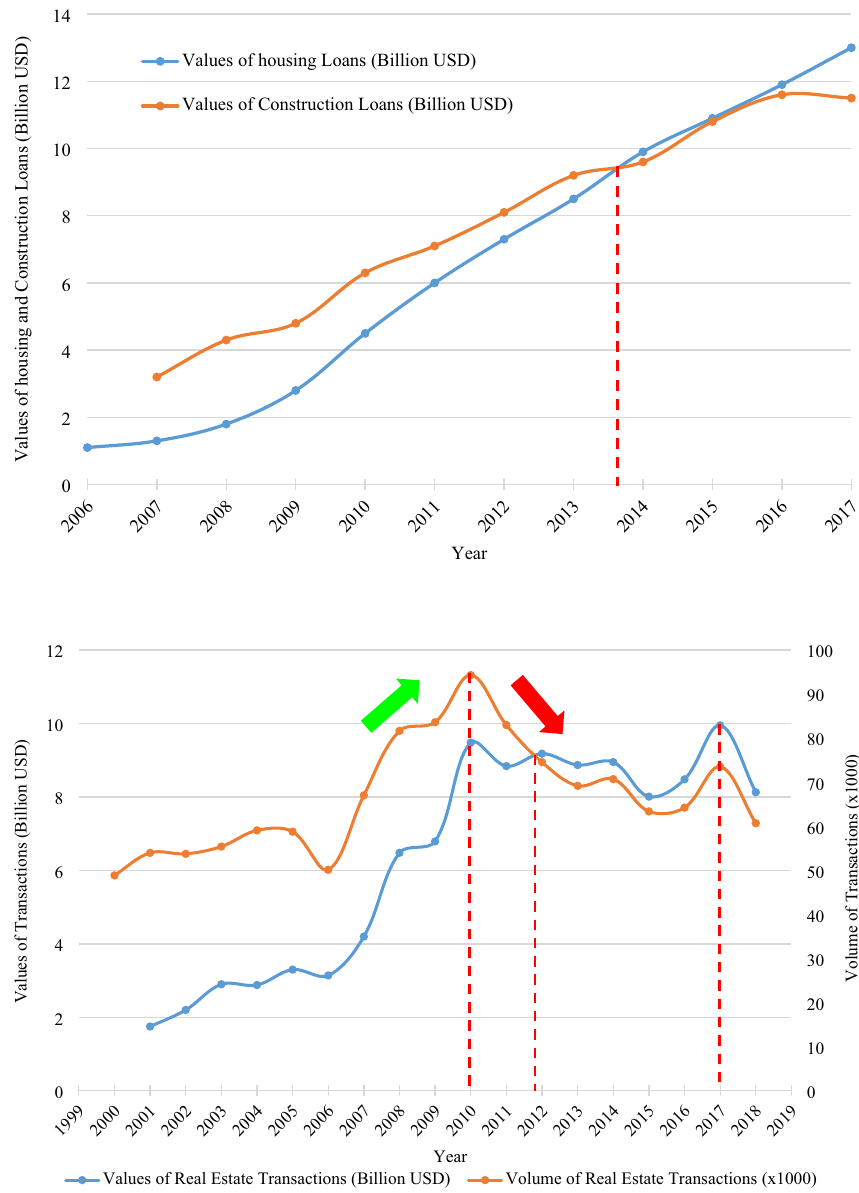
Fig. 5 Values of housing and Construction Loans ( Source : BankMed [46, 47, 52]; Credit Libanais [49], GPG [53])